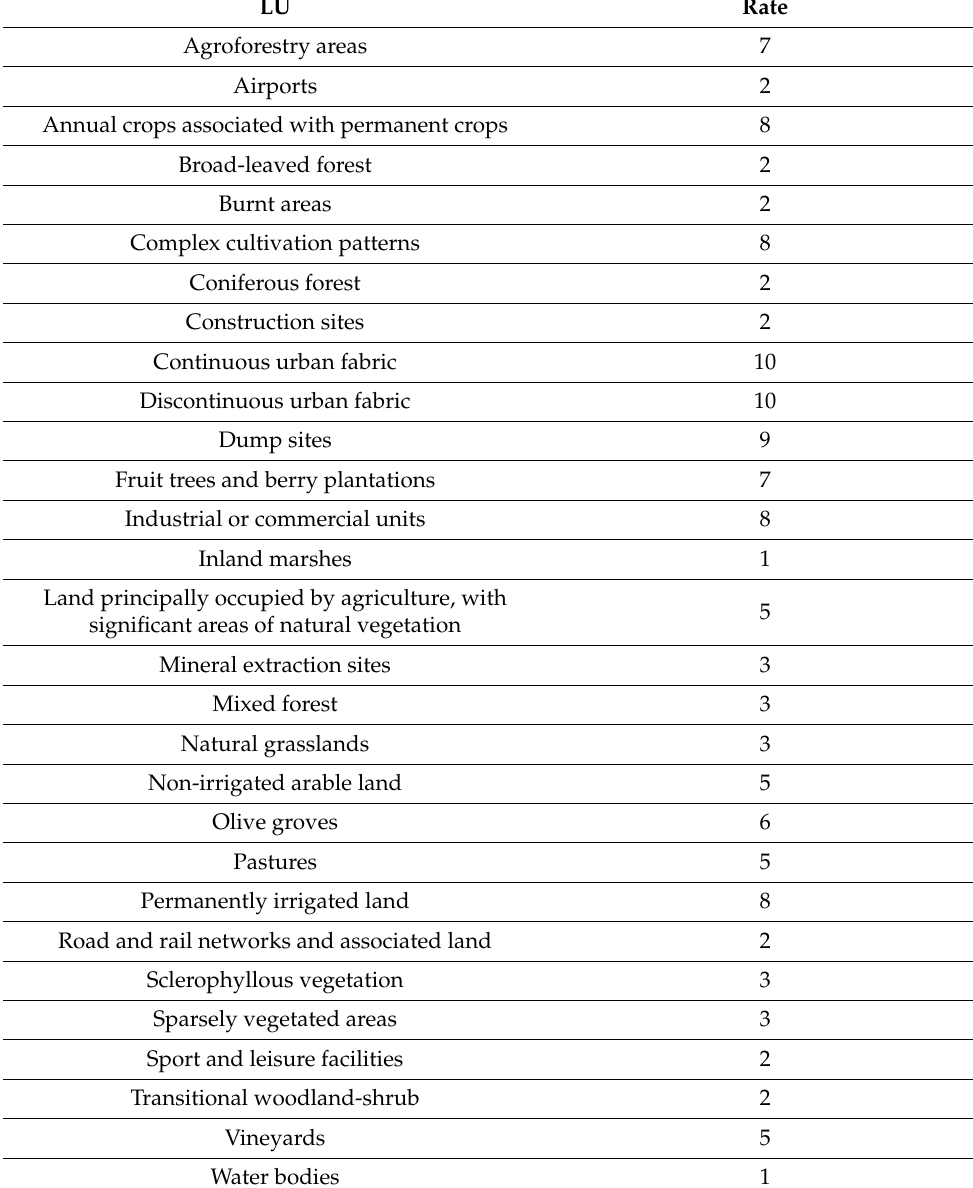
Table 2. Rates of land use